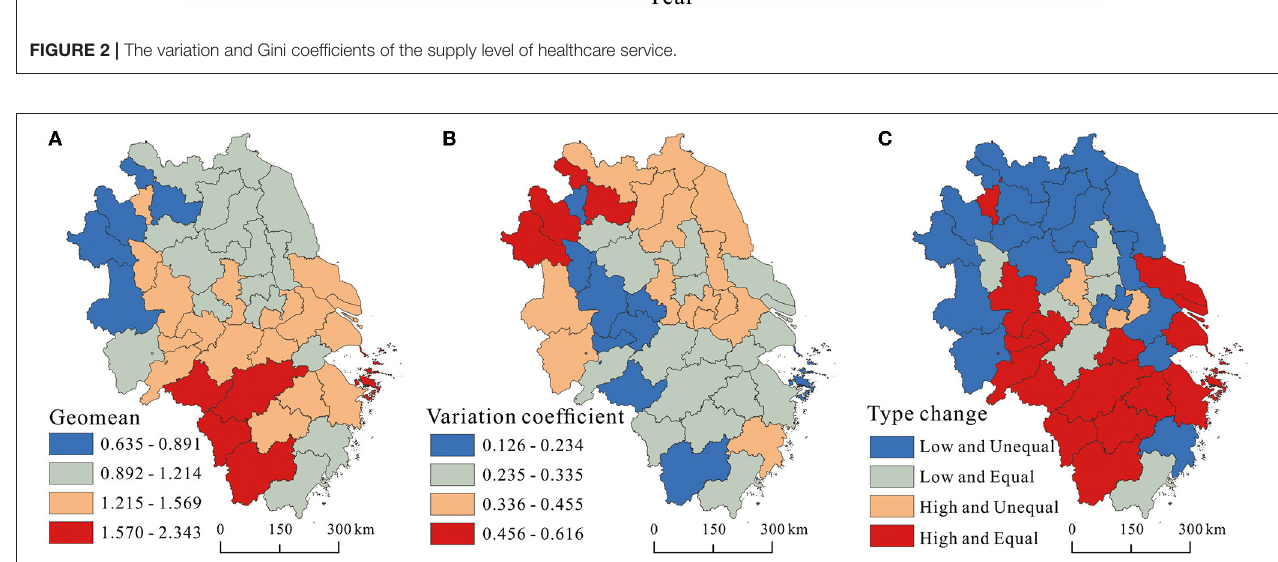
FIGURE 3 | The coefficient of variation (CV) and Gini coefficient of the supply level of healthcare